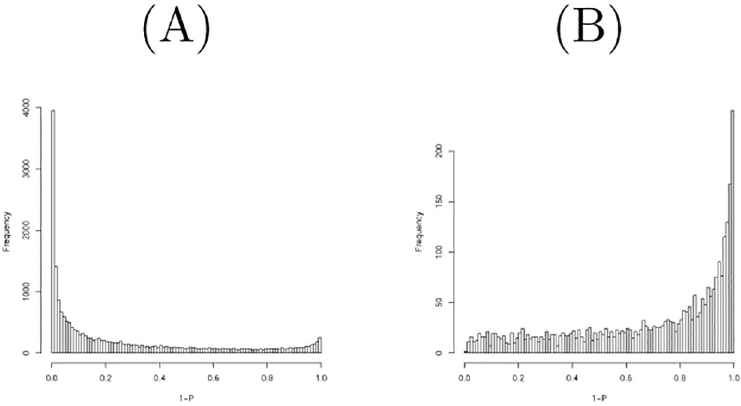
Fig 2. Histogram of raw P -values computed using the null distribution generated by shuffling when the mRNAs in the first data set were considered. (A) All mRNAs (B) Top 3000 most expressive mRNAs.